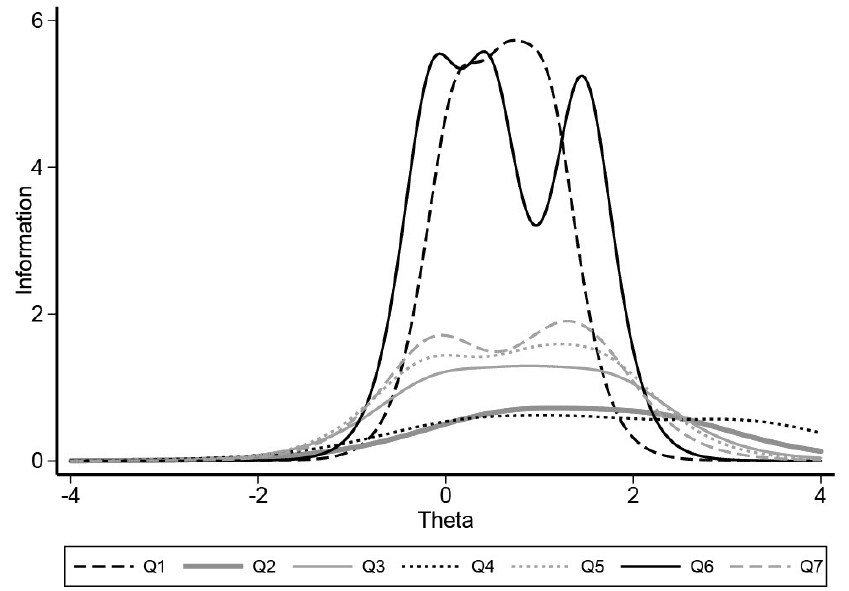
Figure 2. Figure 2 shows the item information functions for the seven domains of the FCM.